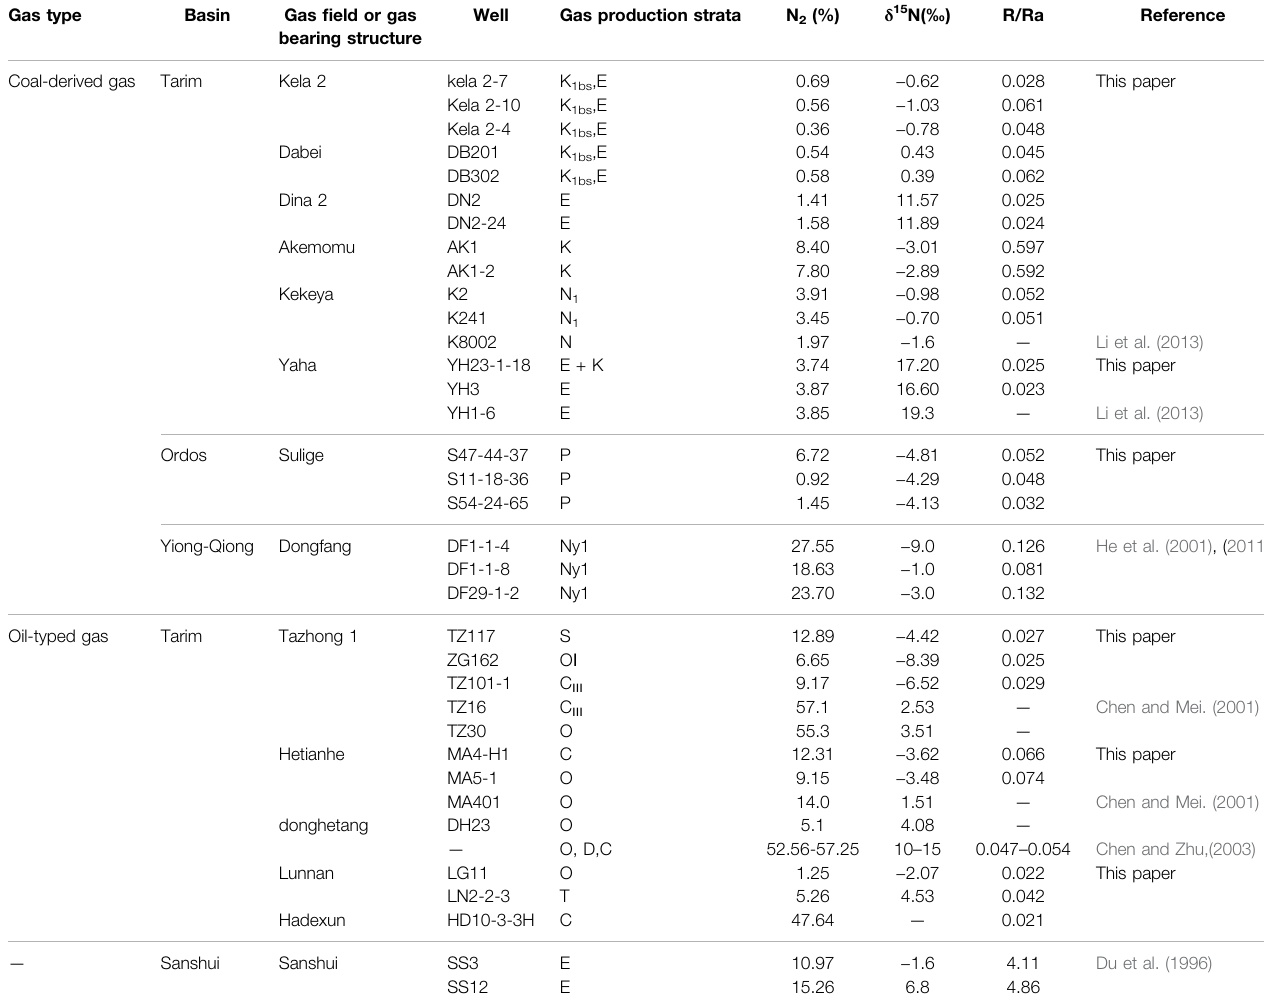
TABLE 1 | Composition and isotope data of non-hydrocarbon gases of nitrogen and helium in some typical coal-derived gas and oil-typed gas in China. Gas